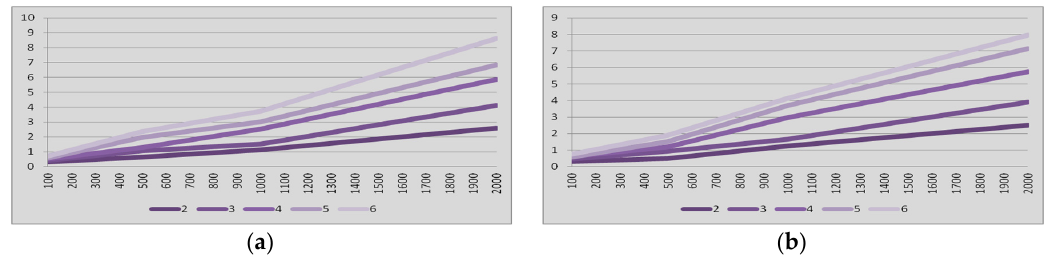
Figure 7. Latency (vertical, seconds) vs. inactivity interval (horizontal, milliseconds). Links always in sniff mode. From two to six hops. ( a ) master-to-slave communication; ( b ) slave-to-master communication.